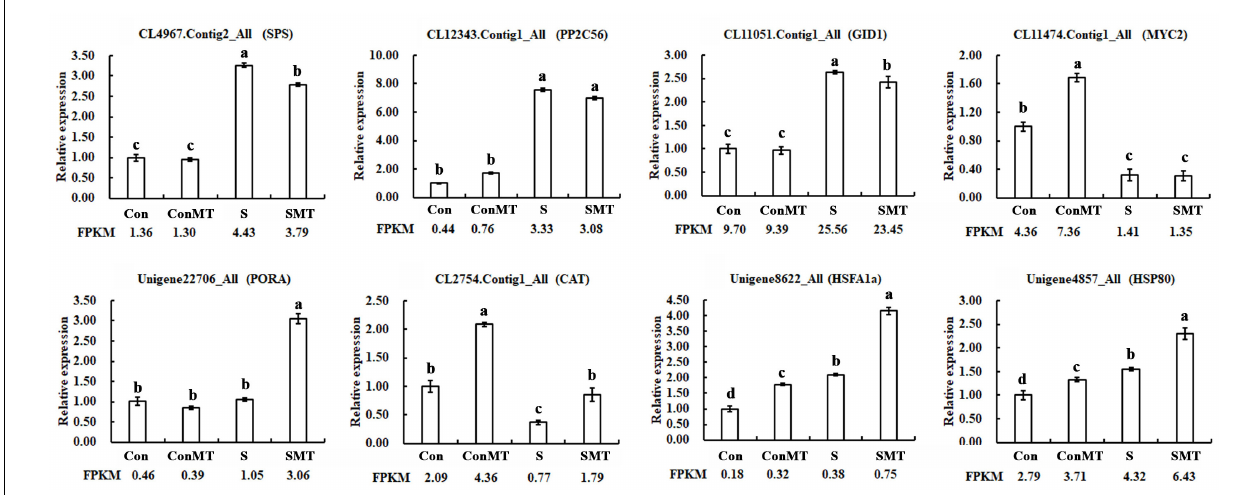
FIGURE 4 | Use of qRT-PCR to verify the accuracy of RNA-Seq. Con, control; S, heat stress; SMT, heat stress with exogenous melatonin treatment; ConMT, control with exogenous melatonin treatment. Error bars represent SE ( n = 3). Duncan’s multiple range test was used for significant difference analysis, and different letters indicate a significant difference at P < 0.05.